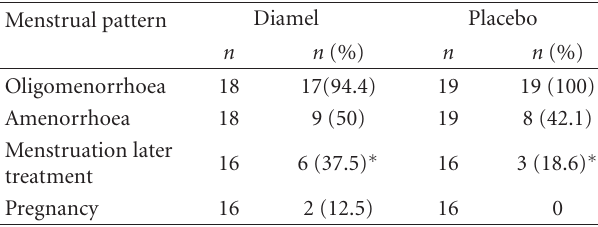
Table 7: Menstrual pattern in patients with polycystic ovary syndrome at the start and after the treatment. Menstrual pattern Diamel Placebo